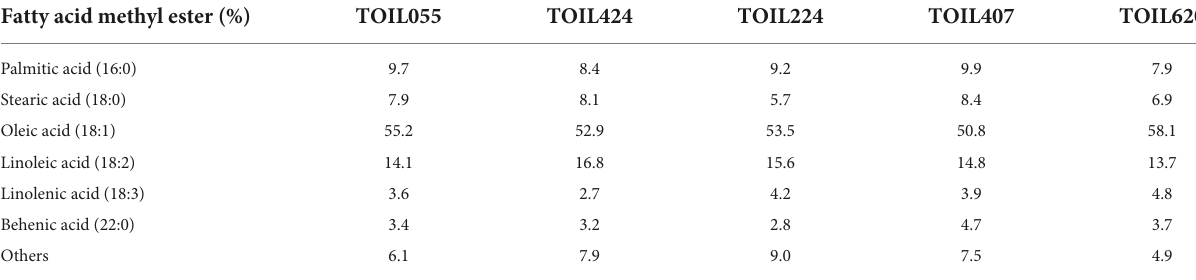
TABLE 2 Fatty acid methyl esters (FAMEs) analysis of oil extracted from five different pongamia